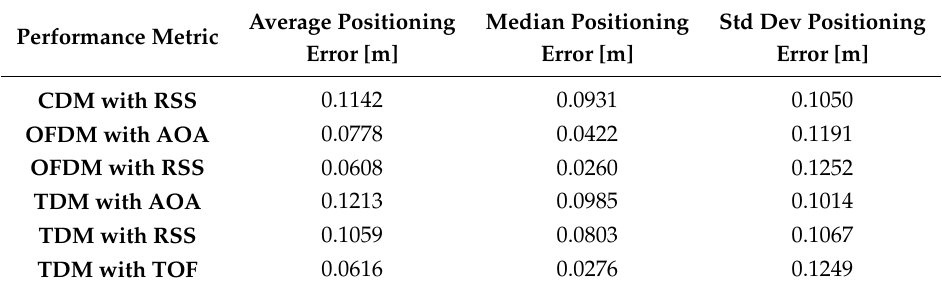
Table 7. Fine Phase Positioning: Average, Median, and Standard Deviation of Positioning Error.